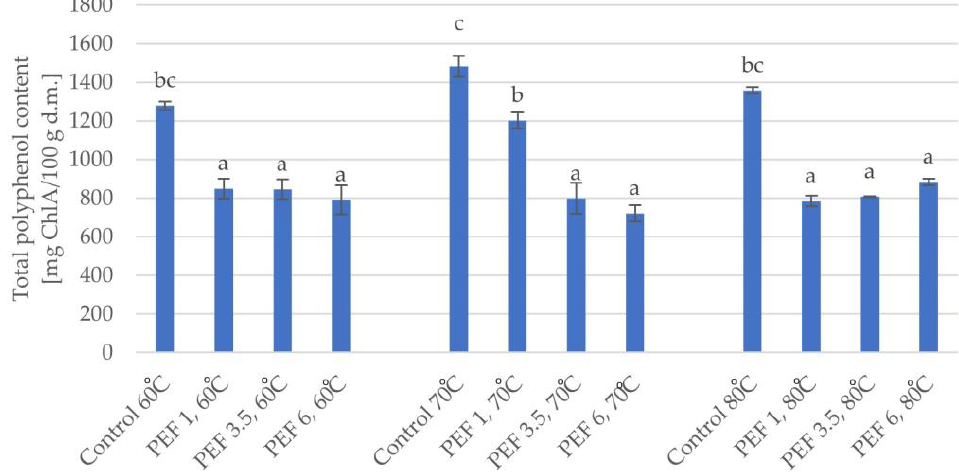
Figure 4. Total polyphenol content of dried apple tissue obtained using different values for the parameters of pulsed electric field intensity (1, 3.5, and 6 kJ/kg) and hot air drying temperature (60, 70, and 80 ◦ C) ( n = 2). The columns with different letters are significantly different ( p < 0.05). Analyzing the results obtained when the drying temperature was at 80 ◦ C, it can be seen that an increase in the PEF pretreatment intensity resulted in a slight increase in the total polyphenol content in the apple tissue; however, it should be highlighted that the highest value for total polyphenol content was found in the dried apple tissue obtained without pulsed electric field pretreatment. For example, apple tissue pretreated with a